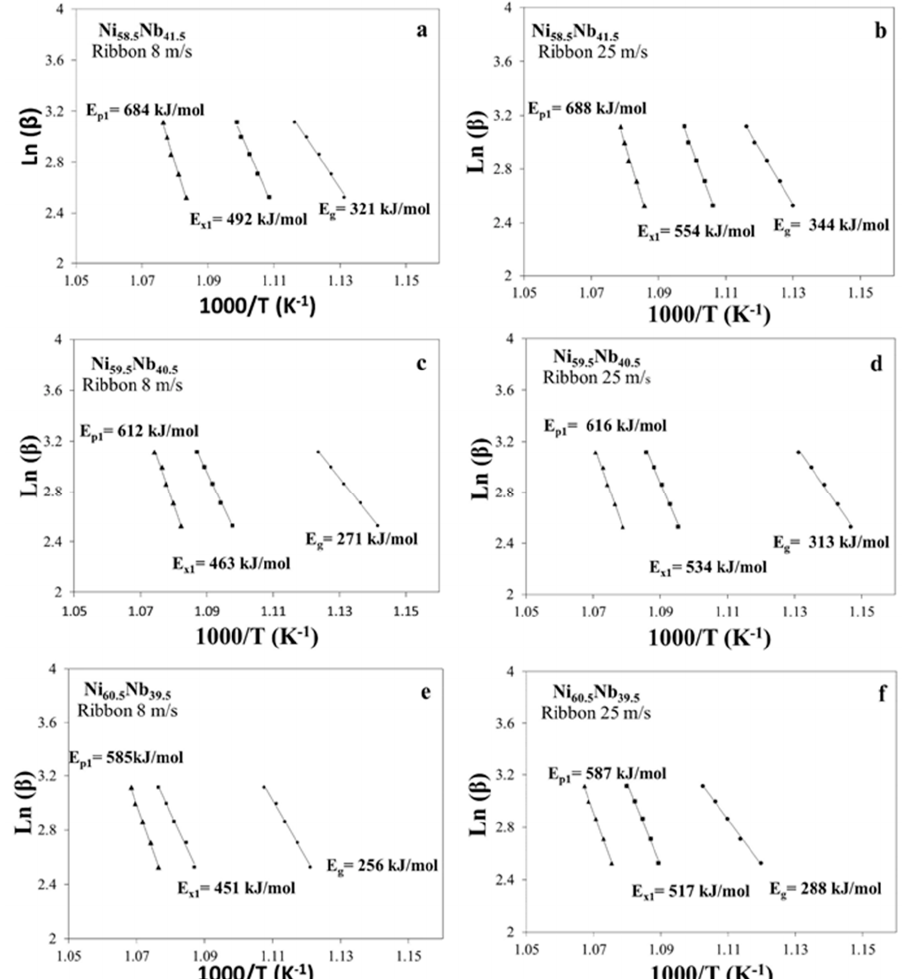
Figure 6. ( a – f ) . Flynn–Wall–Ozawa calculated with Ln ( β /T 2 ) vs. 1000/T (T= T g , T x1 and T p1 ) for 8 m/s ( a , c , e ) and 25 m/s ( b , d , f ) cast ribbons for the Ni 58.5 Nb 41.5 , Ni 59.5 Nb 40.5, and Ni 60.5 Nb 39.5